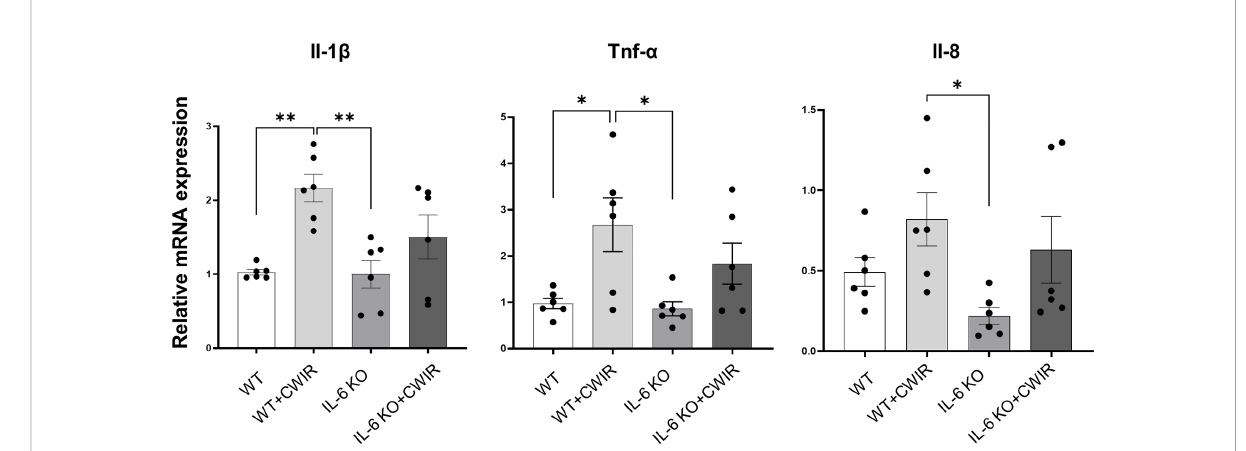
FIGURE 4 IL-6 KO alleviated CWIR-mediated in fl ammatory cytokine expression in the jejunum. Relative mRNA levels of proin fl ammatory cytokines, including Il-1 b , Tnf- a , and Il-8 , were evaluated. Data analysis was performed by two-way ANOVA with the Tukey post-hoc test. N=6, * P <0.05, ** P <0.01.